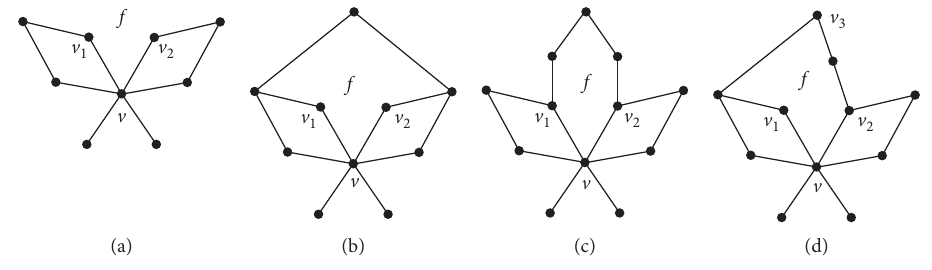
Figure 3: Cases of Lemma